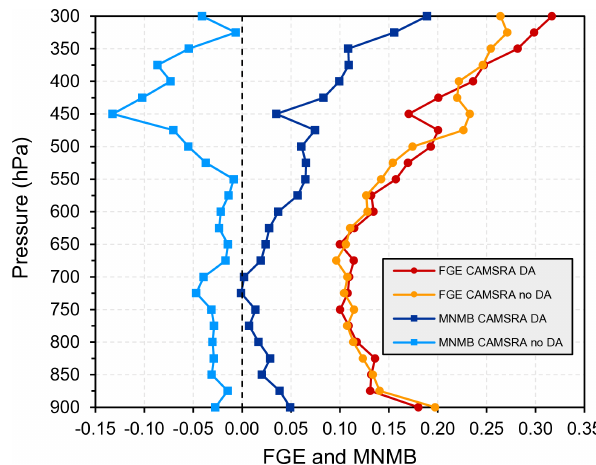
Figure 7. Vertical profiles of median (among examined sites) FGE and MNMB for CAMSRA O 3 with and without chemical data as- similation (DA and no DA,